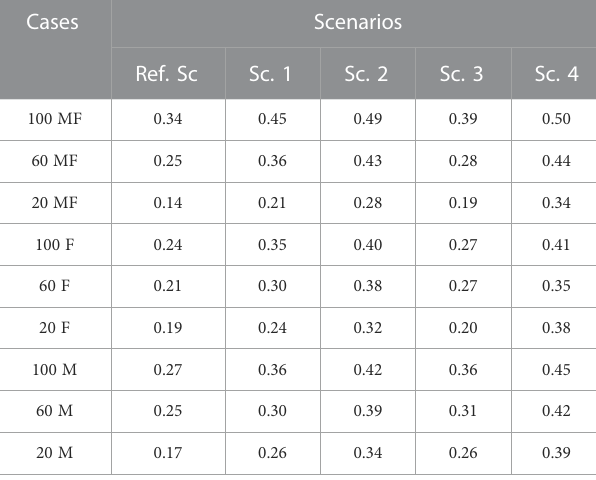
TABLE 3 Prediction accuracy across scenarios under different phenotyping